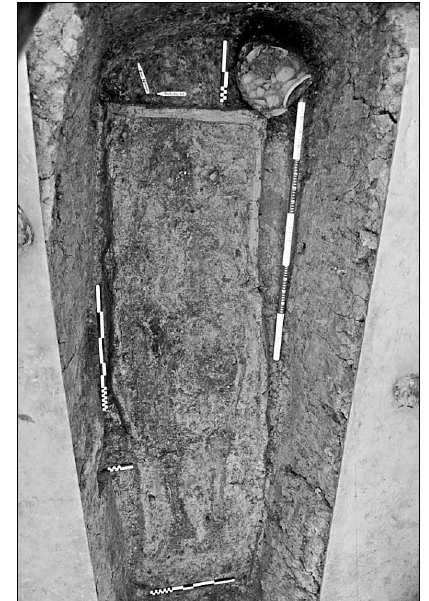
Figure 5 Warrior burial B20, looking south, showing the butt beaker (upper right) and outline of the container; the stain of the skeleton is faintly visible (vertical scale bar at left